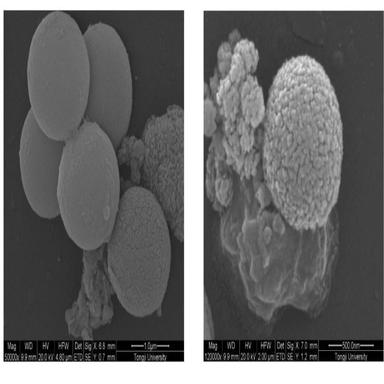
Morphology of silica microsphere (a), (b) without pore expansion and (c), (d) with pore expansion.